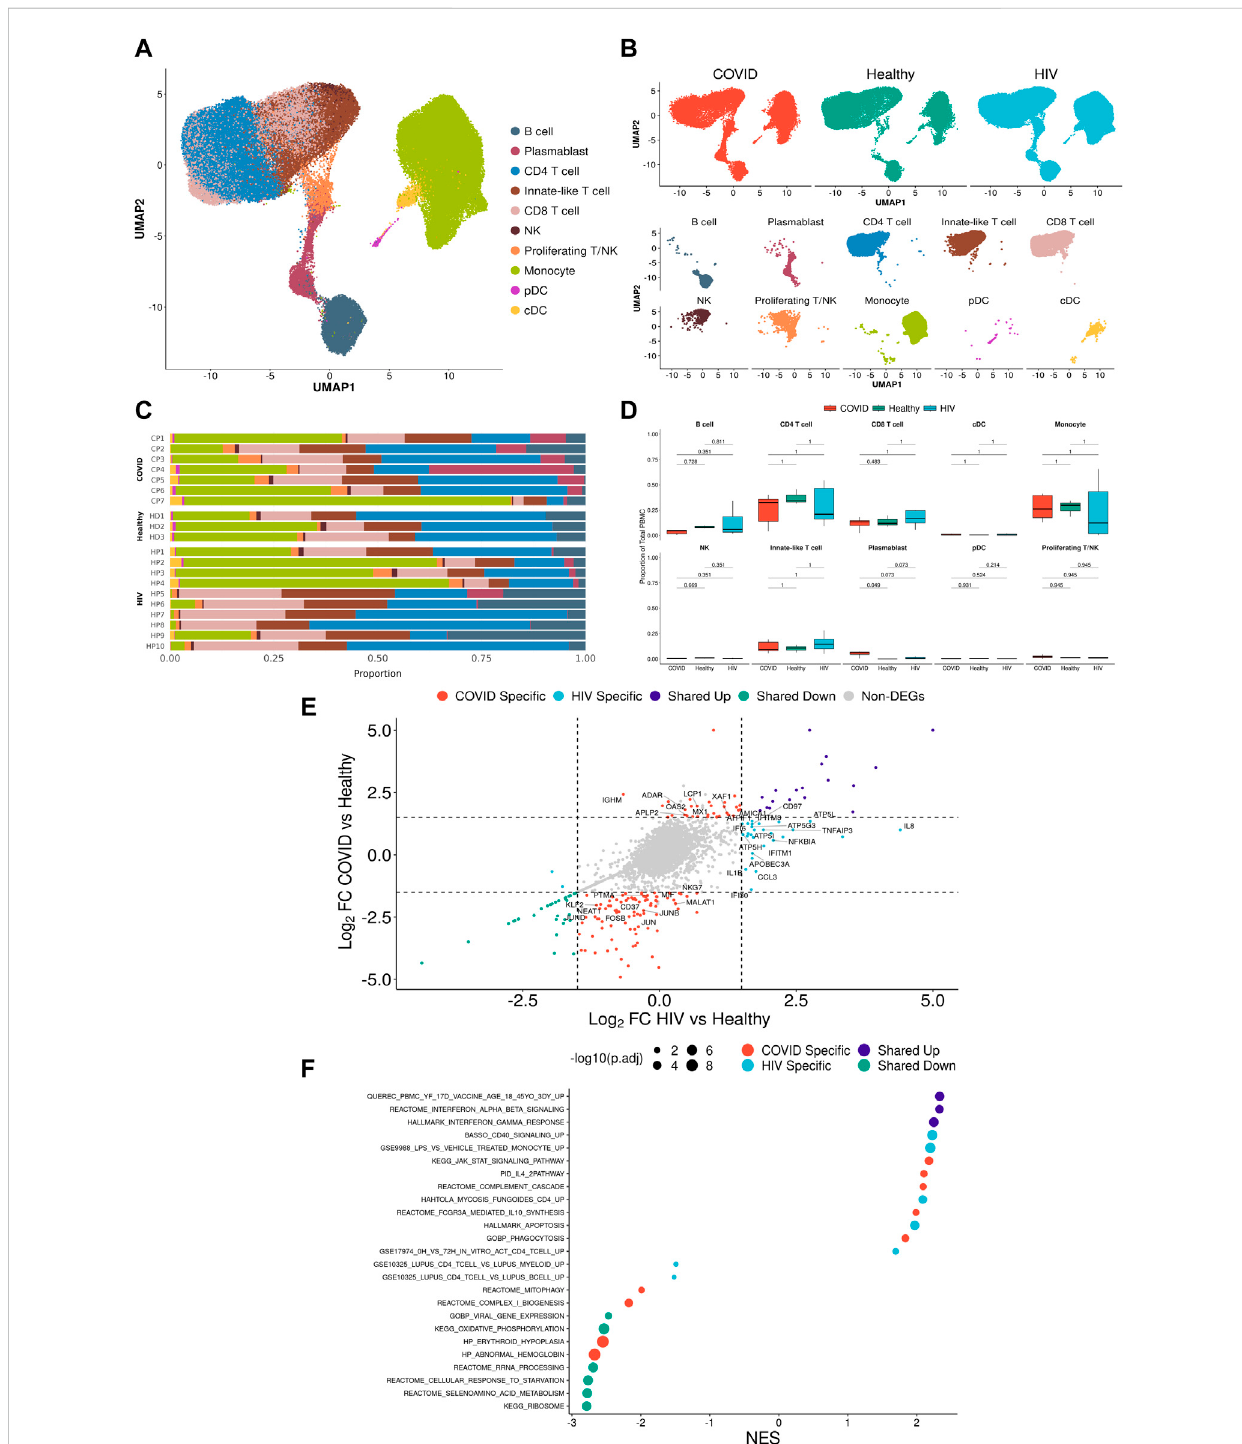
FIGURE 2 Integrated single-cell landscape of PBMC in HIV-1, COVID-19, and healthy controls. (A) UMAP embeddings of integrated HIV-1 + and COVID-19 patients together with healthy controls colored by major cell populations. (B) Top: UMAP split across disease conditions after regressing out patient- speci fi c effects using the Harmony algorithm. Bottom: UMAP highlighting distribution of major cell populations. (C) Stacked bar plots of the relative frequency of major cell populations present in each patient. CP: COVID-19 patient. HP: HIV-1 + patient. HD: Healthy donor. (D) Box plots of the proportions of each PBMC subset across each disease condition. Proportions are computed for each patient by dividing their number of cells in each subset by their total number of PBMCs. p -values are computed with Wilcoxon signed-rank test with Holm-Bonferroni adjustment. (E) Double differential gene expression plot of genes that are differentially expressed between COVID-19 patients compared to healthy controls ( Y -axis) or differentially expressedbetweenHIV-1 + patientscomparedtohealthycontrols( X -axis).Log2FC:Log-2-foldchange. (F) Dotplotofenrichedbiologicalpathwaysfrom signi fi cantly differentially expressed genes ( p < .05) that were found to be upregulated (right, positive) or downregulated (left, negative) compared to healthy controls. Size of dot corresponds to adjusted p -value of enriched pathway. NES: Normalized enrichment